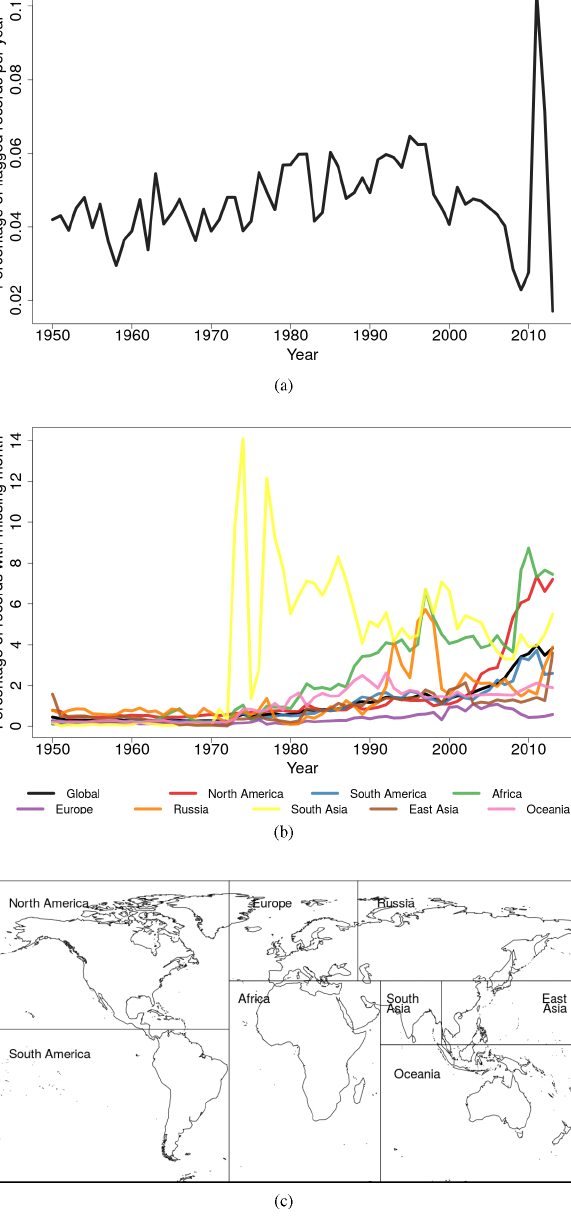
Figure 4. Percentage of records that (a) failed one or more qual- ity control tests and were flagged and (b) were not used as input for interpolation due to missing monthly totals and hence missing anomaly values. Panel (c) shows a map of regions as used for (a) and (b)